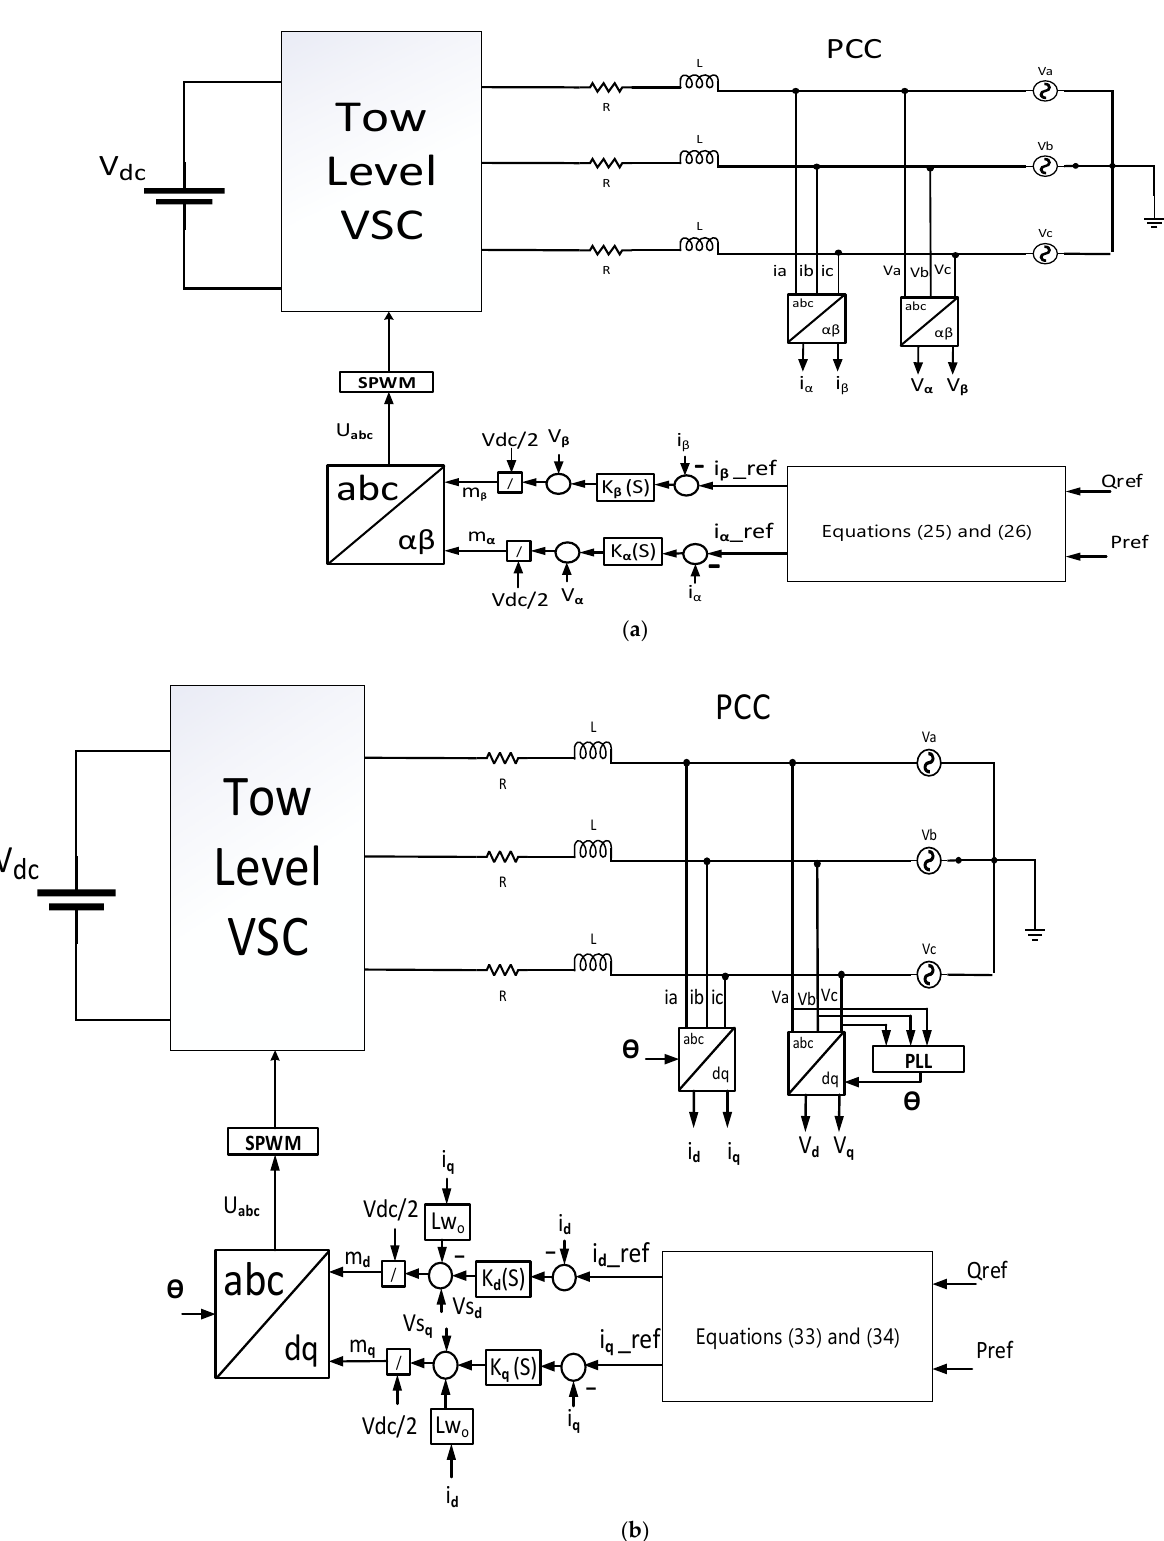
Figure 11. Studied system configurations with two-level inverter using ( a ) the αβ controller and ( b ) the dq controller.